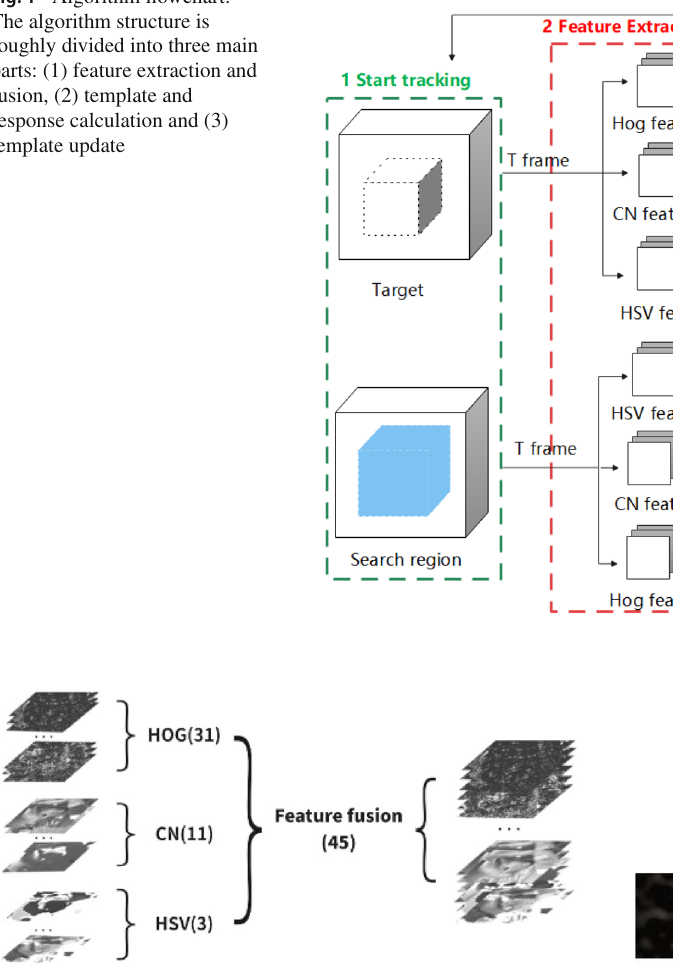
Fig. 2 A fusion features provides a 45-dimensions including 31-dimensional HOG feature, 11-dimensional CN feature and 3- dimensional HSV feature